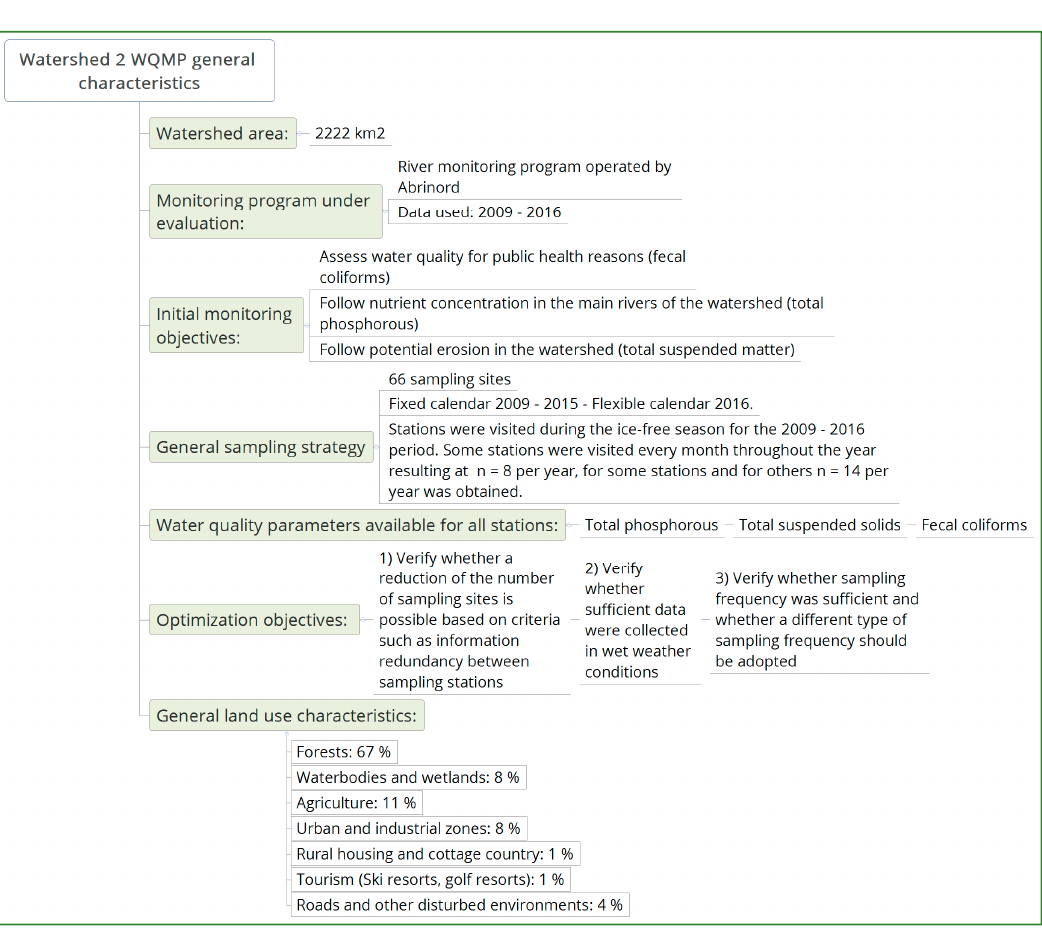
Figure 3. Outline of the Rivière du Nord WQMP (W2) and the three optimization objectives retained for this paper